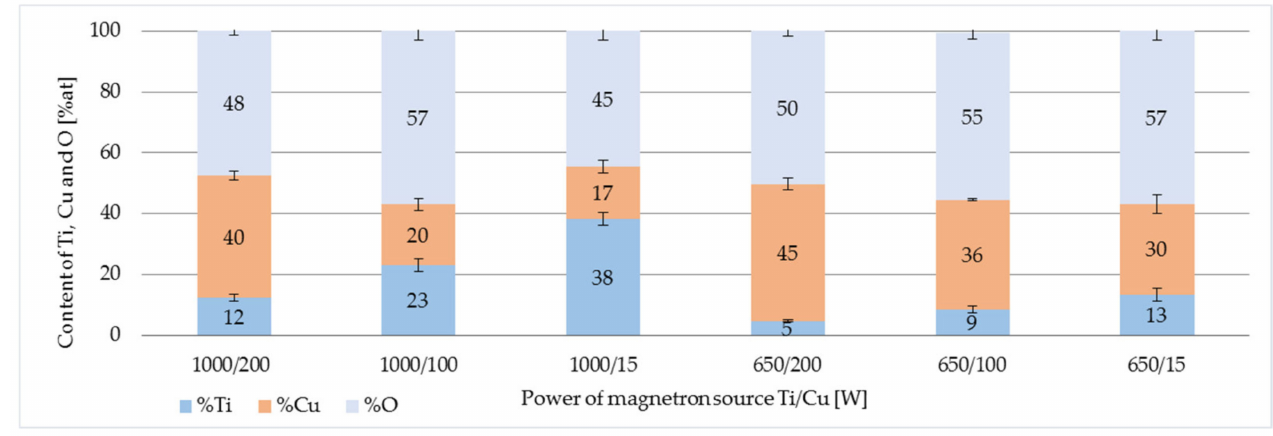
Figure 4. Elemental composition of TiO 2 + CuO coatings deposited at different power of magnetron